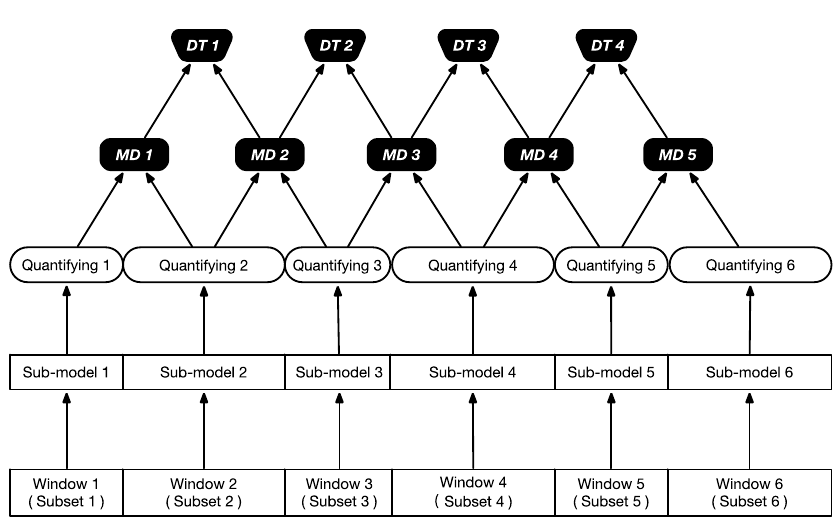
Figure 5. Adaptive mechanism—Model Difference (MD) and Difference Trend (DT).